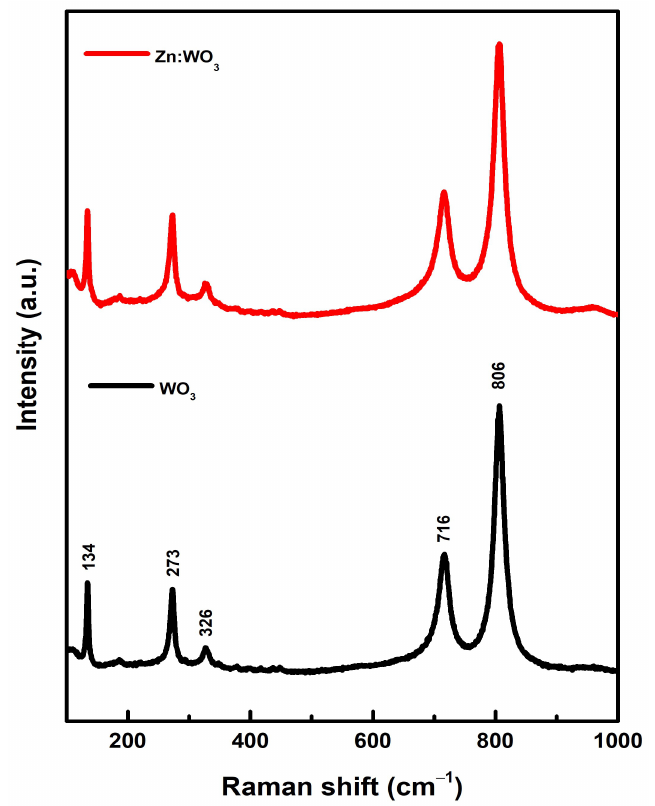
Figure 2. Raman spectra of WO 3 and Zn: WO 3 films.